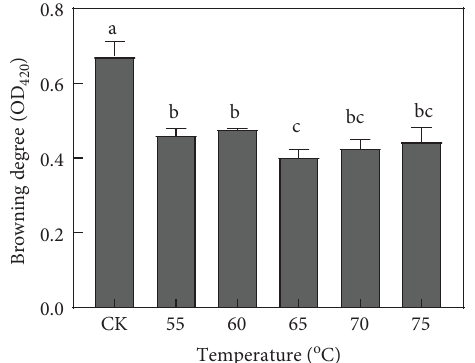
Figure 2: Browning degree of “Yali” pear paste prepared under traditional heating and vacuum concentration with diferent temperatures. CK: pear paste under traditional heating concen- tration; 55 ° C, 60 ° C, 65 ° C, 70 ° C, and 75 ° C: pear paste at diferent vacuum concentration temperatures; diferent letters indicated signifcant diferences among groups ( p < 0 . 05).